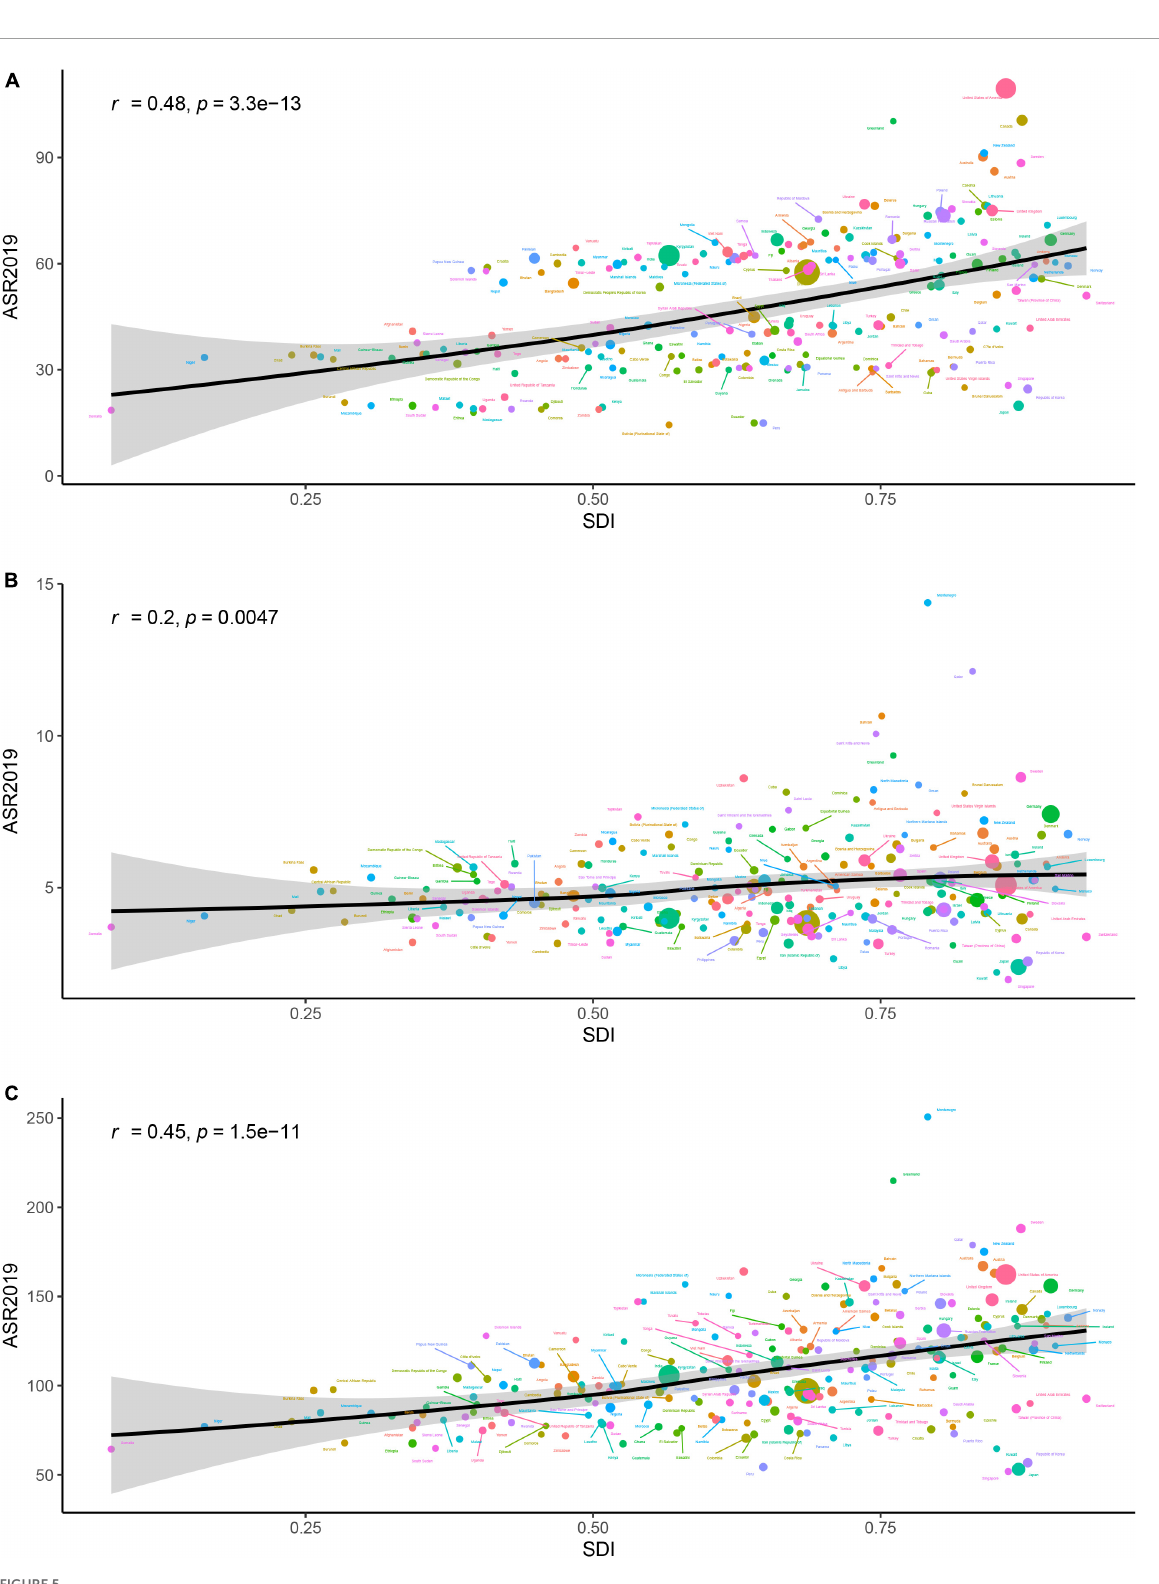
FIGURE5 The association between age-standardized incidence rate (ASR) of atrial fibrillation and socio-demographic index (SDI) for 204 countries and territories in 2019. Expected values are shown as the black line. The r indices and P -value were derived from Pearson correlation analysis. (A) Age-standardized incidence rate. (B) Age-standardized death rate (ASDR). (C) Age-standardized disability-adjusted life-year (DALY)